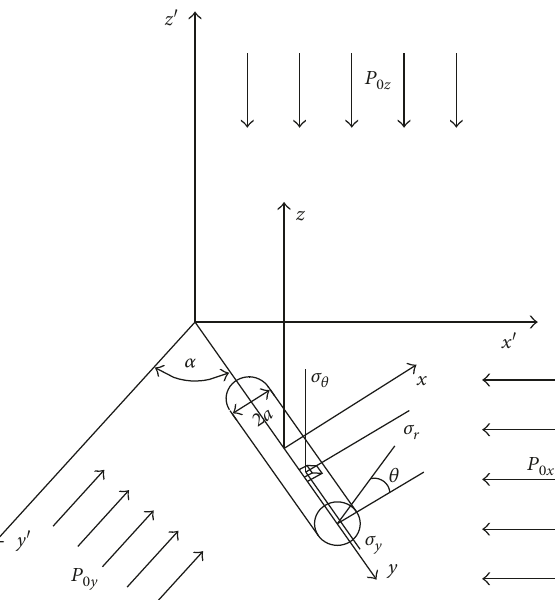
Figure 2: The numerical model of the roadway in a random